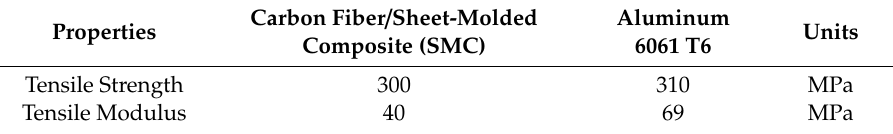
Table 2. Mechanical properties of composite and aluminum